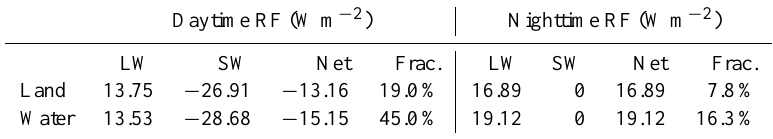
Table 1. Radiative day- and nighttime forcing of the tracked contrails (median values). In percent, the fraction of contrails in each case.